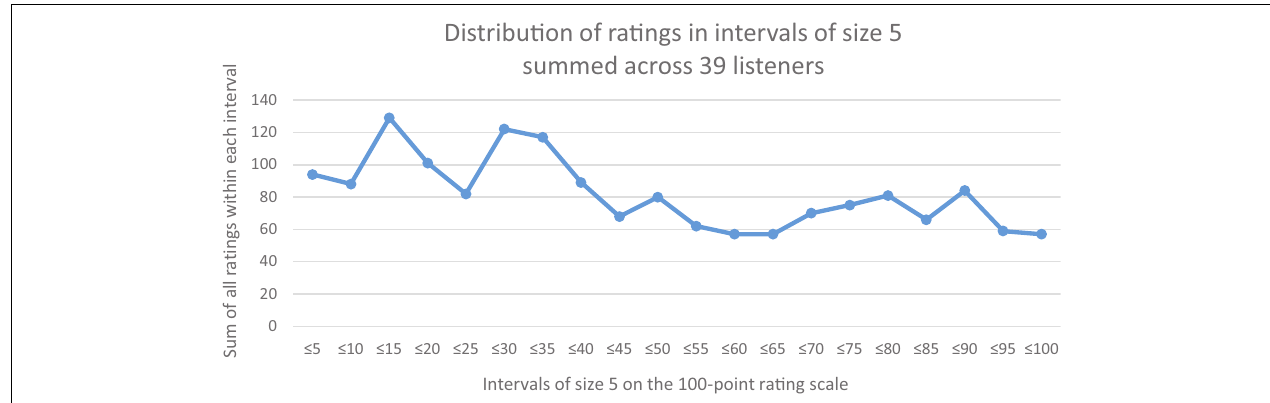
FIGURE 1 | Number of mean ratings across the ten trials within all listeners across the entire 100-point scale in intervals of size 5. The figure illustrates that the entire rating scale was used by the listeners, that is, that ratings occurred within all the intervals of possible ratings. To understand the figure, note that each of 39 listeners produced 42 mean ratings over 10 trials on each of the 42 stimuli. Thus the figure represents 42 × 39 = 1638 mean ratings organized in 20 intervals. For example, the interval from 0 to 5 accounted for 94 mean ratings. The interval with the largest number of ratings (129) was 11 to 15, and the intervals with the smallest number of mean ratings (57) were tied at intervals 56 to 60, 61 to 65, and 96 to